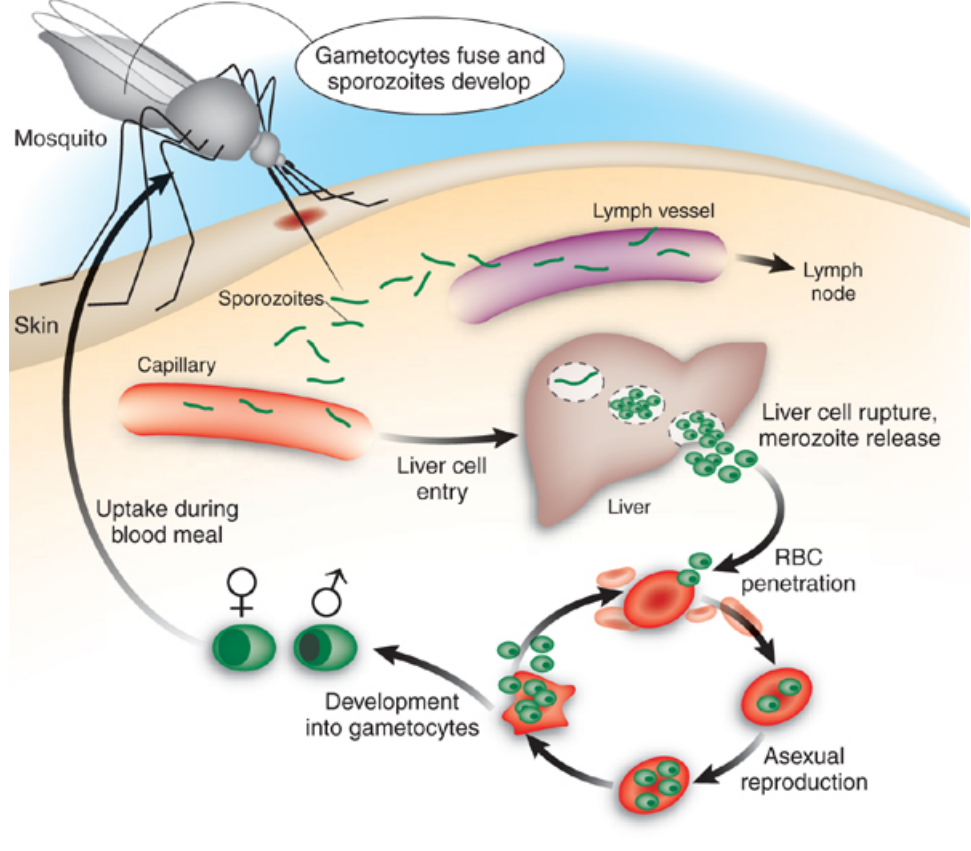
Figure 1. Schematic life cycle of malaria in humans. Sporozoites are injected into human dermis through the bite of infected Anopheles mosquito. After inoculation, sporozoites migrate to liver cells to establish the first intracellular replicative stage. Merozoites generated from this exoerythrocytic phase then invade erythrocytes (RBCs), and it is during this erythrocytic stage that severe conditions of malaria occur. The life cycle is completed when sexual stages (gametocytes) are ingested by a mosquito. Some sporozoites deposited in the skin eventually penetrate capillaries or lymph vessels. Those entering the lymph vessels will penetrate lymph vascular endothelial cells in lymph nodes to establish a lymph node form, which appears not to continue the life cycle - but may be significant in priming an immune response. Adapted and reproduced by permission from Macmillan Publishers Ltd.